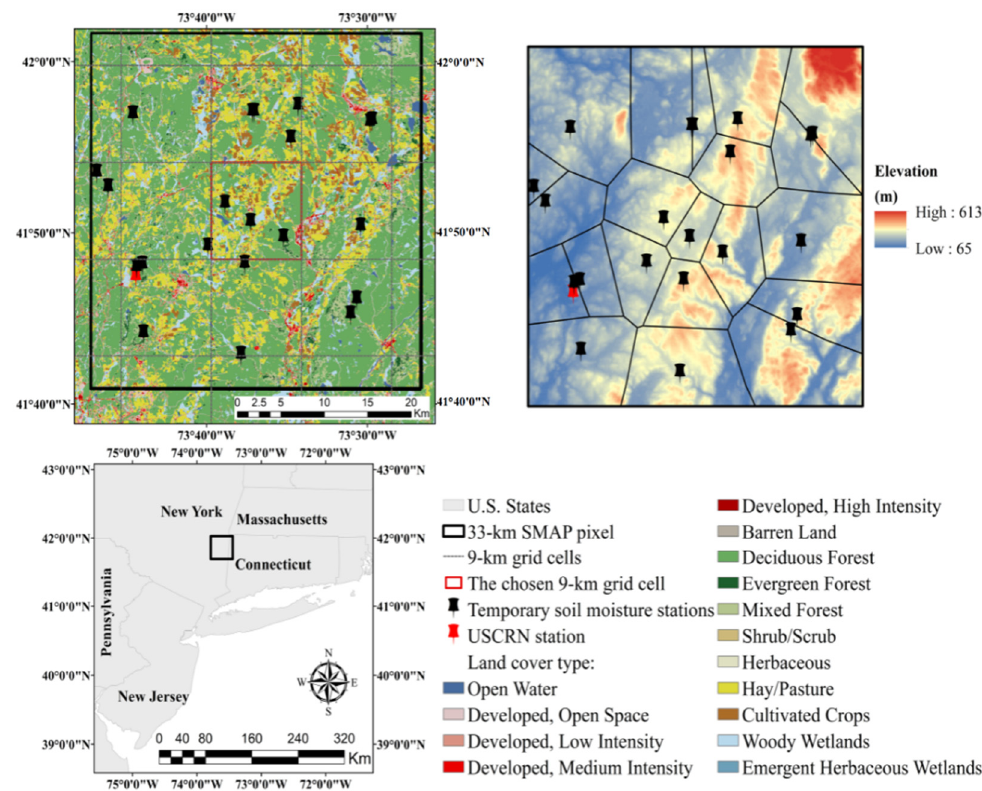
Figure 1. The land use cover, digital elevation model, and geographical location of the Millbrook site and temporary soil moisture network.